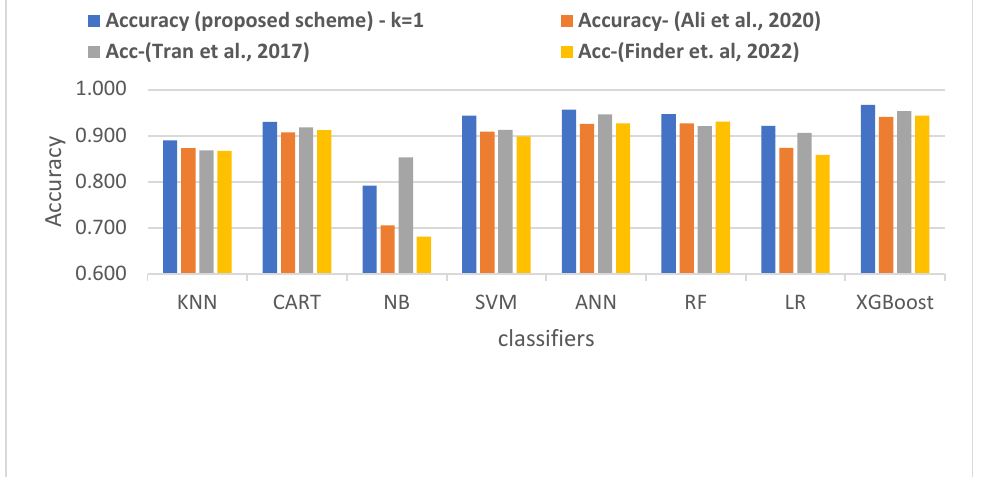
Figure 7. The comparison of the Detection Accuracy between the proposed DIEBD-based scheme and the related work-based schemes.